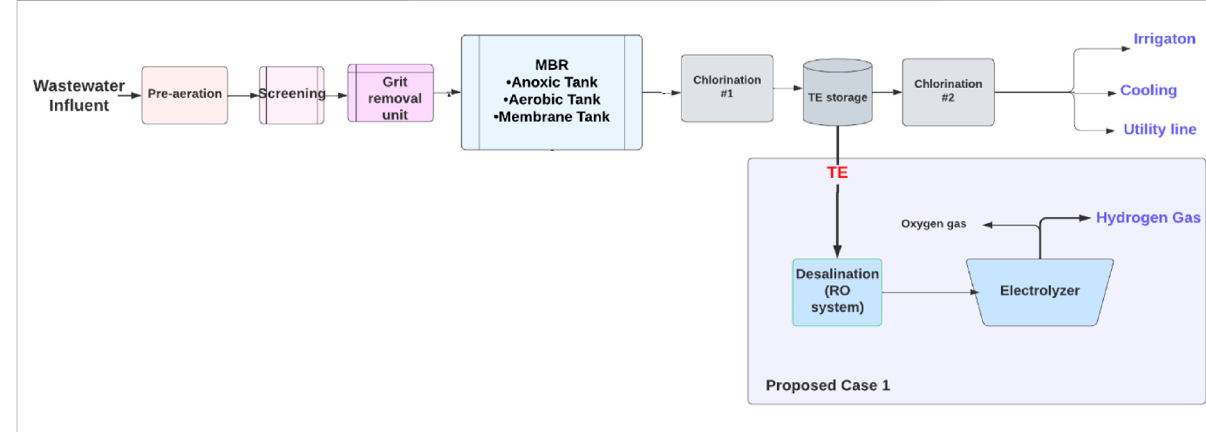
FIGURE 5 The Al Ansab sewage treatment plant with water reclamation opportunities.